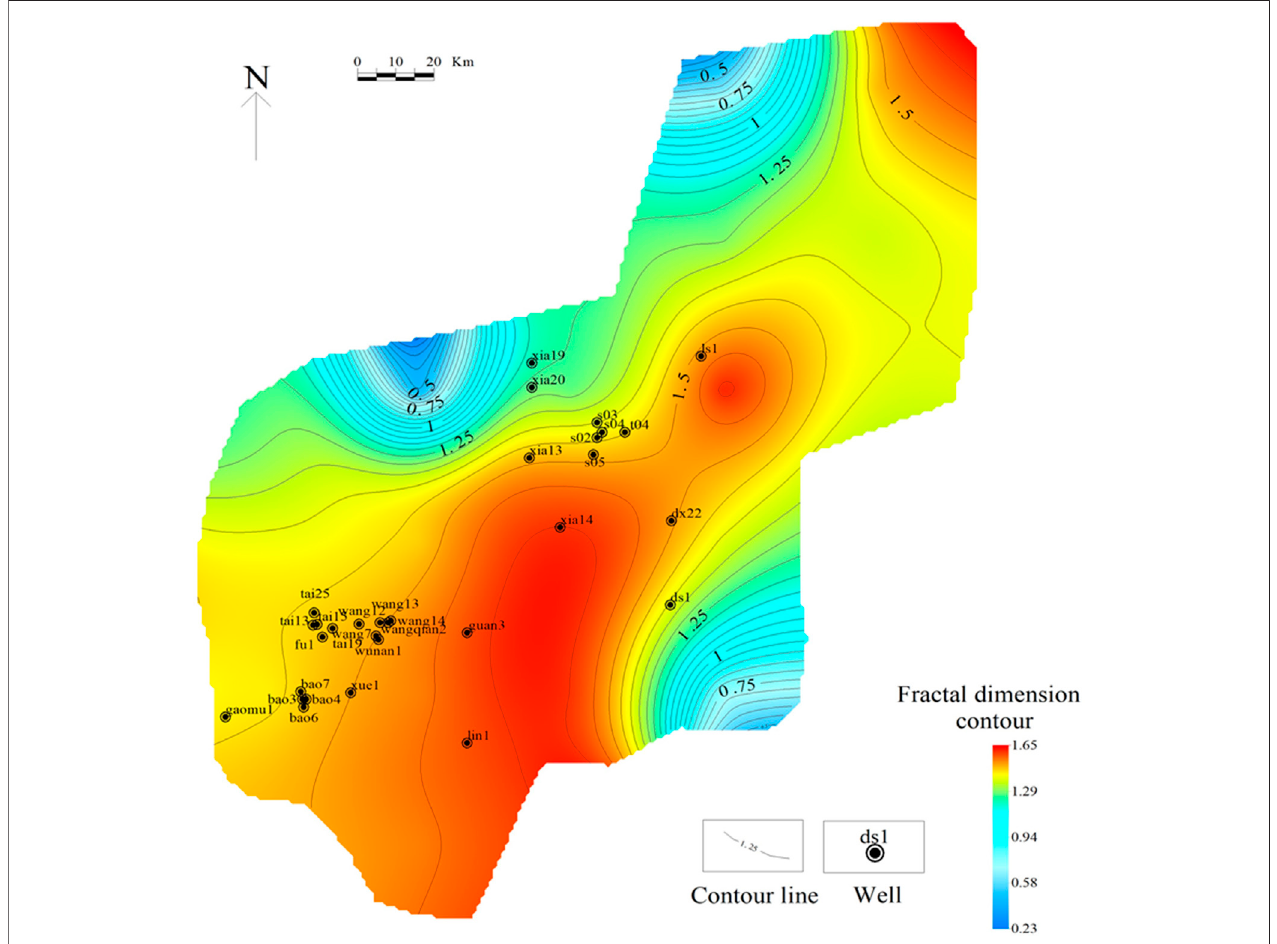
FIGURE 6 | Contour map of fractal dimensions of faults in Maokou Formation in southeast Sichuan (q = 1)